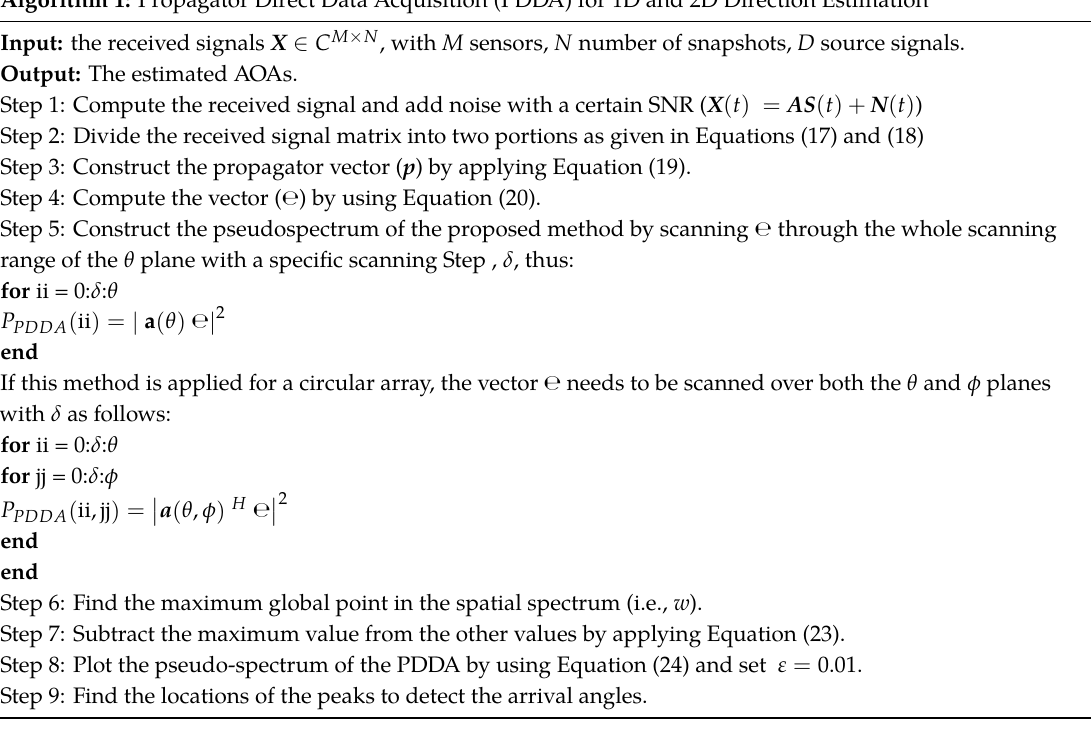
Algorithm 1: Propagator Direct Data Acquisition (PDDA) for 1D and 2D Direction